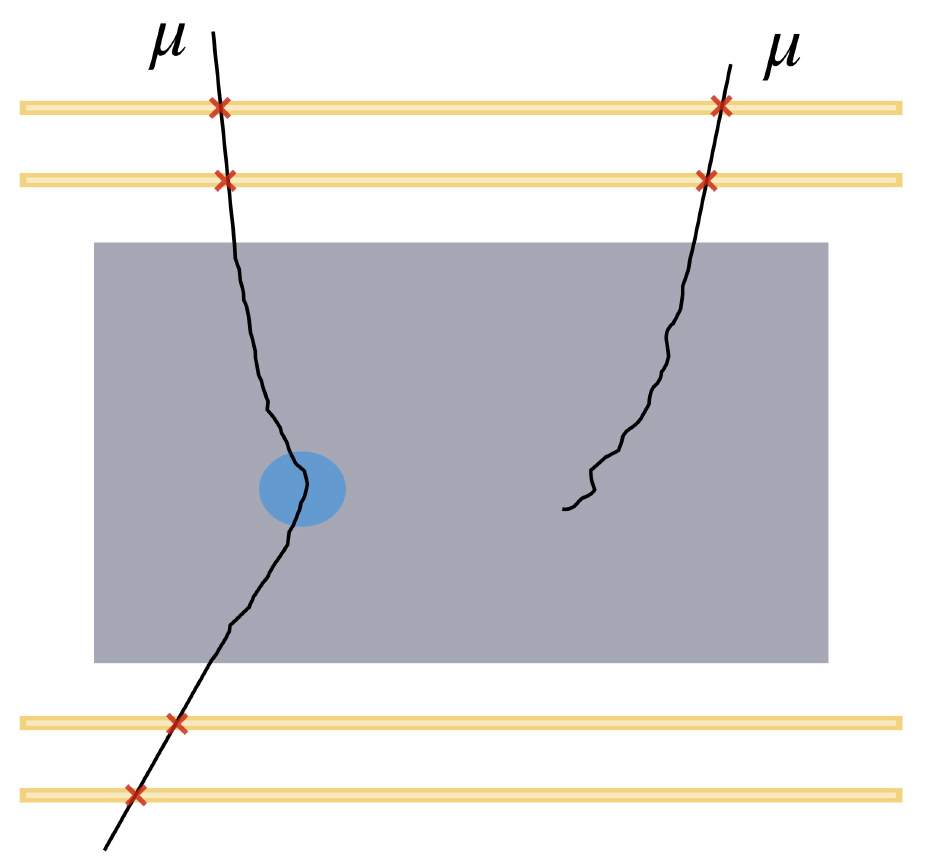
Figure 2. Muon scattering ( left ) and muon absorption ( right ) in